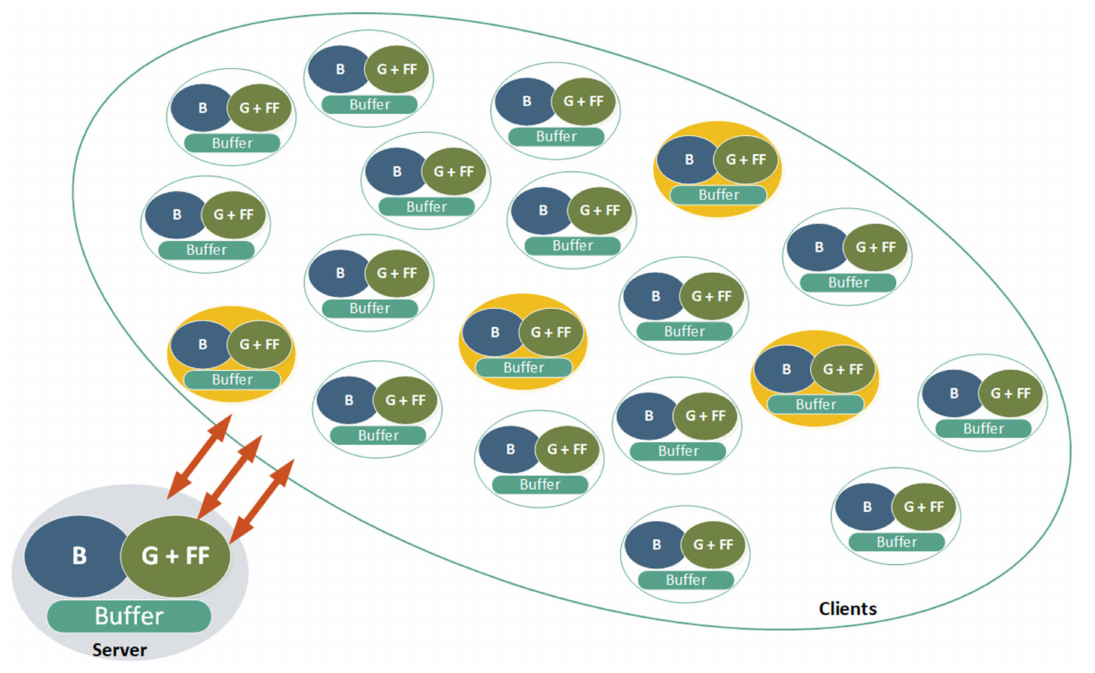
Figure 5. Hybrid deployment approach with unified node structure– the overview.